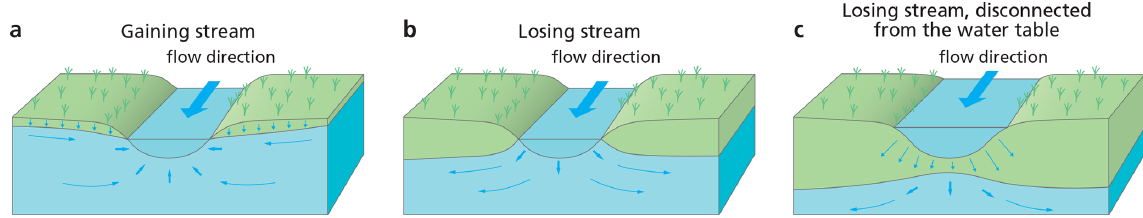
Figure 1. Groundwater–streamflow interaction: (a) gaining stream; (b) losing stream; (c) losing stream disconnected from the water table, modified from Winter at al. (1998). Credit to the United States Geological Survey.